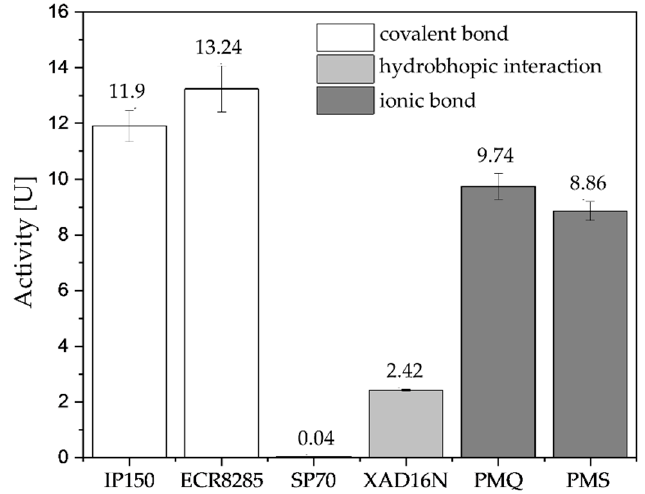
Figure 7. The effect of different carriers on 1-FFT activity. The 10-mL reactions were carried out for 48 h at 25 °C in the presence of 0.2 g of each carrier. Activity [U] = amount of fructose transferred per minute using a standard catalysis protocol.